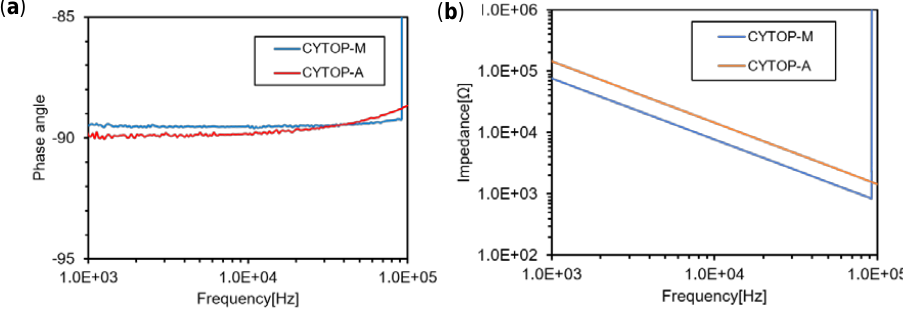
Figure 4. ( a ) Phase angle–frequency curve. ( b ) Impedance–frequency curve. The dielectric constant of CYTOP-M and CYTOP-A were calculated by ( a ) and ( b ) curves at 10 kHz, both CYTOP dielectric were almost same, about 2.1.